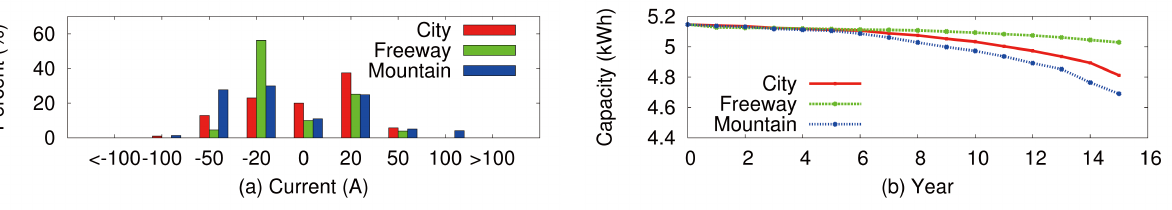
Figure 10. Fuel usage and battery use comparison under different road